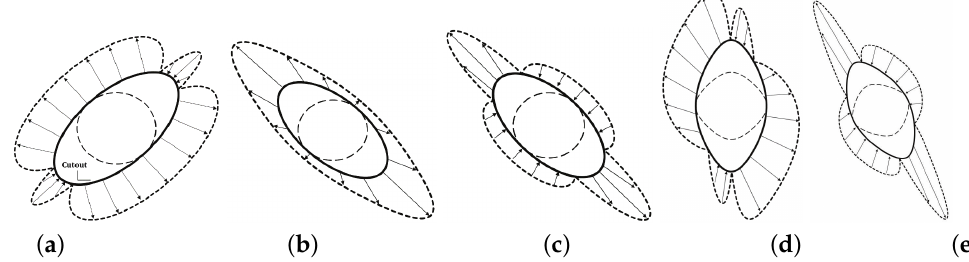
Figure 14. Stress distribution around different cutouts in an optimal condition for isotropic plates: ( a ) uniaxial tensile loading ( w = 0, C.F. = 1.998), elliptical ( c = 2, θ 1 = 45 ◦ , θ 3 = 135 ◦ ); ( b ) equibiaxial loading ( w = 0, C.F. = 3.994), elliptical ( c = 2, θ 3 = 135 ◦ ); ( c ) shear loading ( w = 0, C.F. = 2.998), elliptical ( c = 2, θ 3 = 44.5 ◦ ); ( d ) uniaxial tensile loading ( w = 0.05, C.F. = 2.208), rectangular ( c = 2, θ 1 = 70.13 ◦ , θ 3 = 0 ◦ ); and ( e ) shear loading ( w = 0.05, C.F. = 3.214), rectangular ( c = 2, θ 3 = 26.9 ◦ ). Table 4. Optimal results for circular/elliptical cutout in isotropic plates.